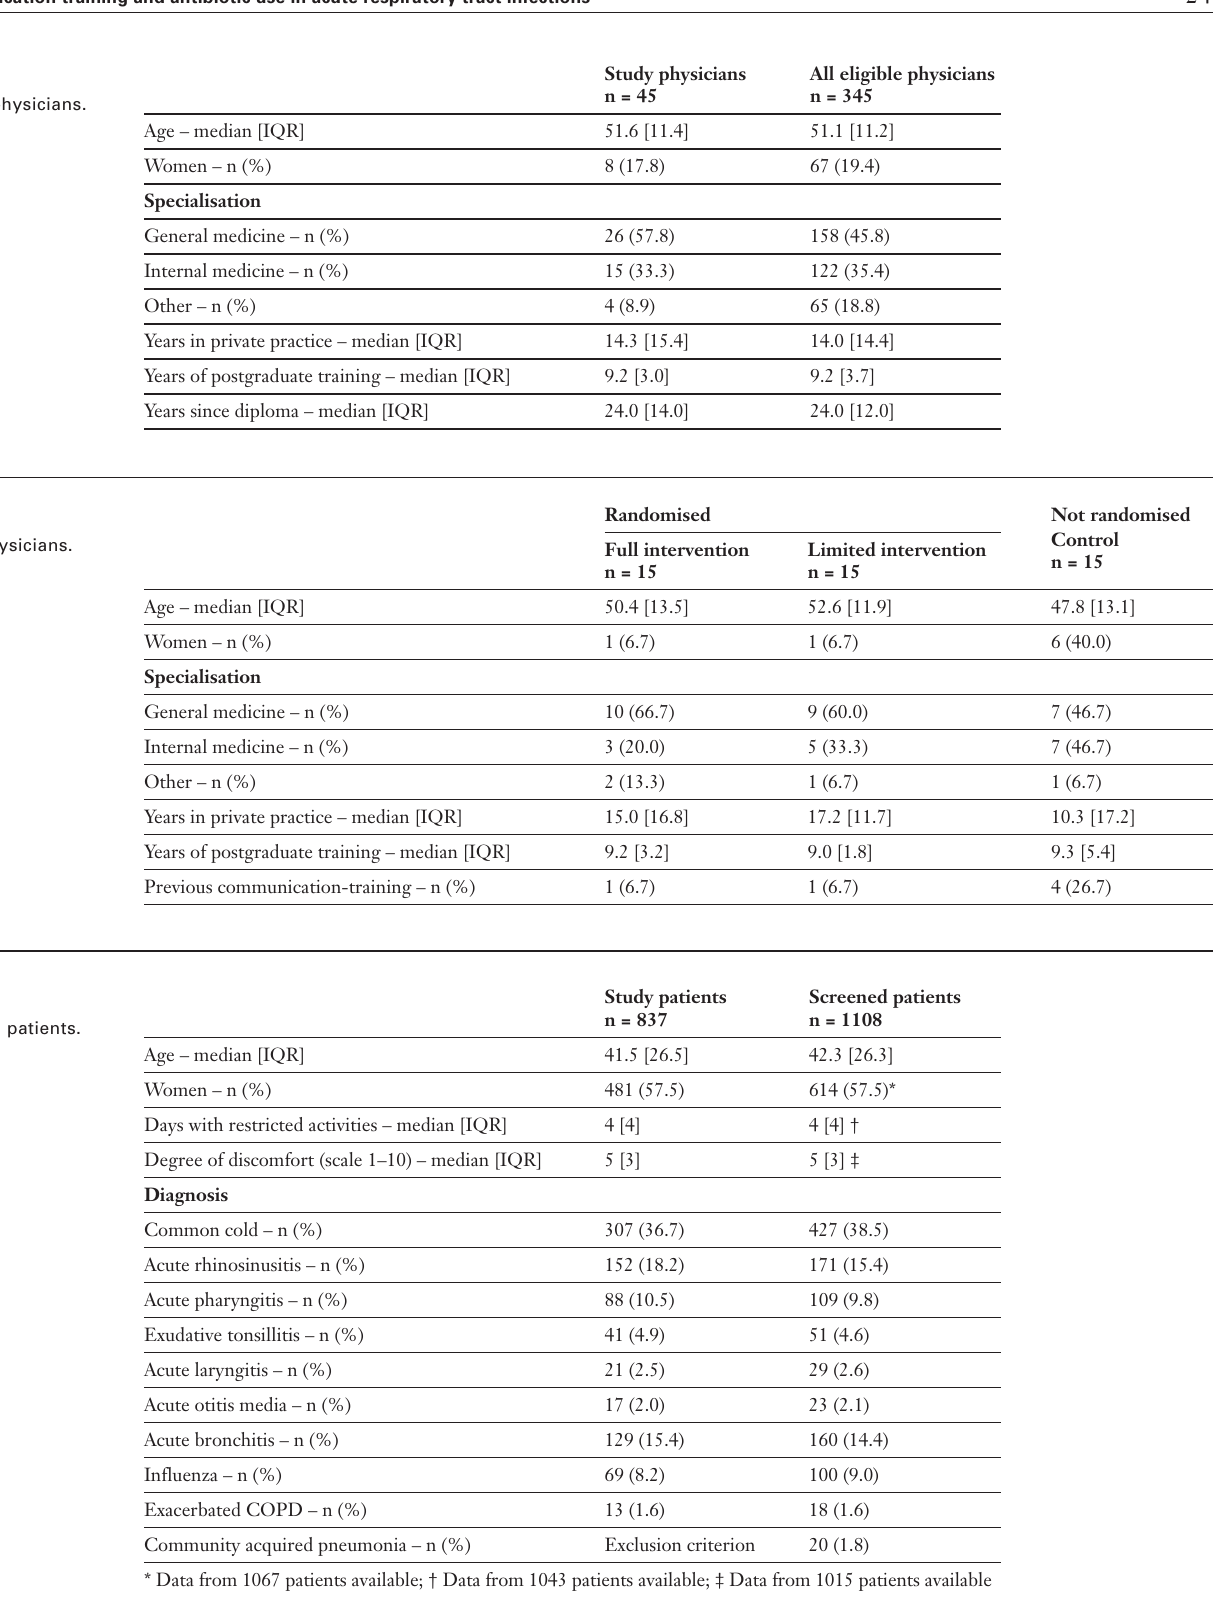
Eligible physicians.